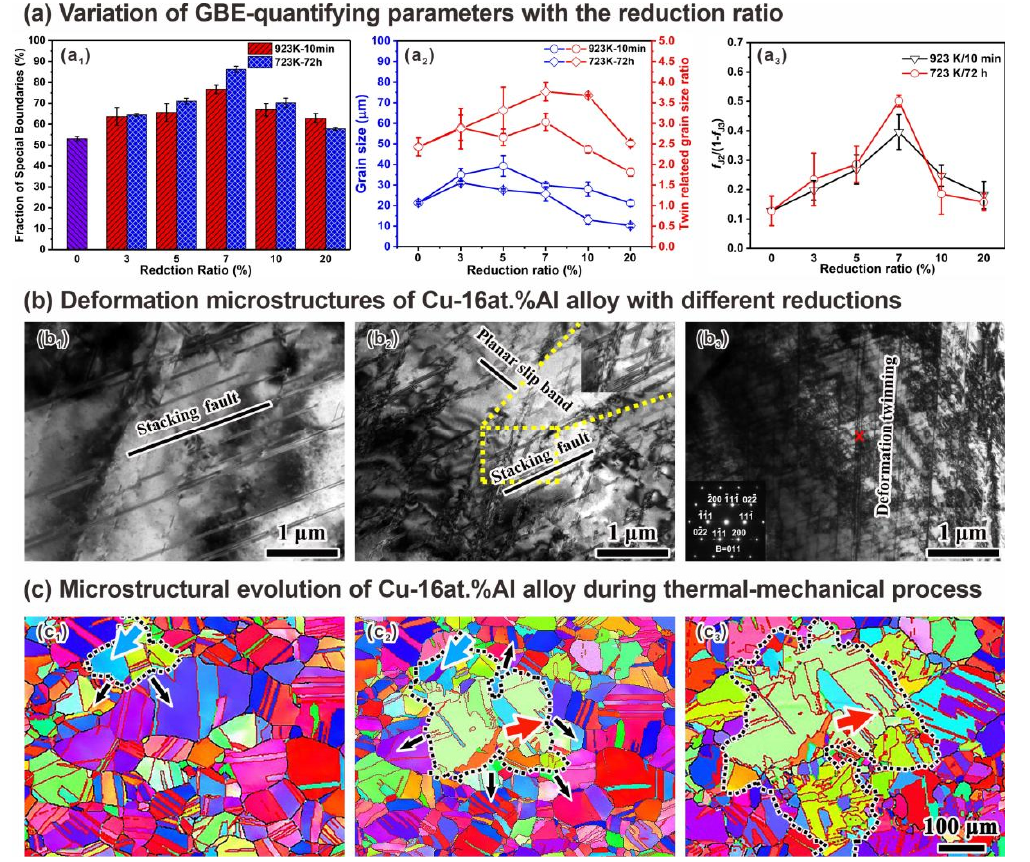
Figure 3. Influence of deformation microstructures on the GBCD optimization of the Cu-16at.%Al alloy ( a ) Variation of GBE-quantifying parameters (a 1 : f SBs , a 2 : ratio of twin- related domain size to grain size, a 3 : triple-junction distribution) with the reduction ratio; ( b ) deformation microstructures at low (3%, b 1 ), optimal (7%, b 2 ), and high (20%, b 3 ) reductions; ( c ) quasi-in situ EBSD observations on the evolution of microstructures during TMP treatment at an optimal stain (7% reduction, c 1 ) and annealing at 723 K for 12 h (c 2 ) and 36 h (c 3 ) . adopted from Ref. [6]